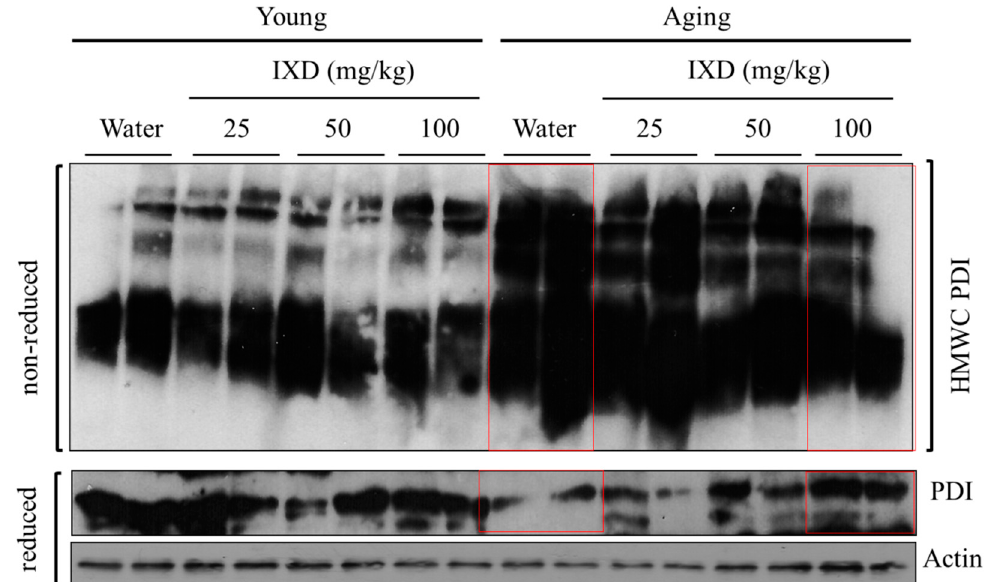
Figure 7. IXD extract regulates the formation of disulfide bonds during protein folding. Whole submandibular gland lysates from the indicated groups were analyzed for the presence of protein disulphide isomerase (PDI) in the high molecular weight complexes (HMWCs) on non-reducing (top panels) and reducing gels (bottom panels). PDI, Protein disulfide isomerase; HMWCs, high molecular weight complexes. Red lines highlight the expression of PDI in water and IXD treated aging submandibular glands lysate.